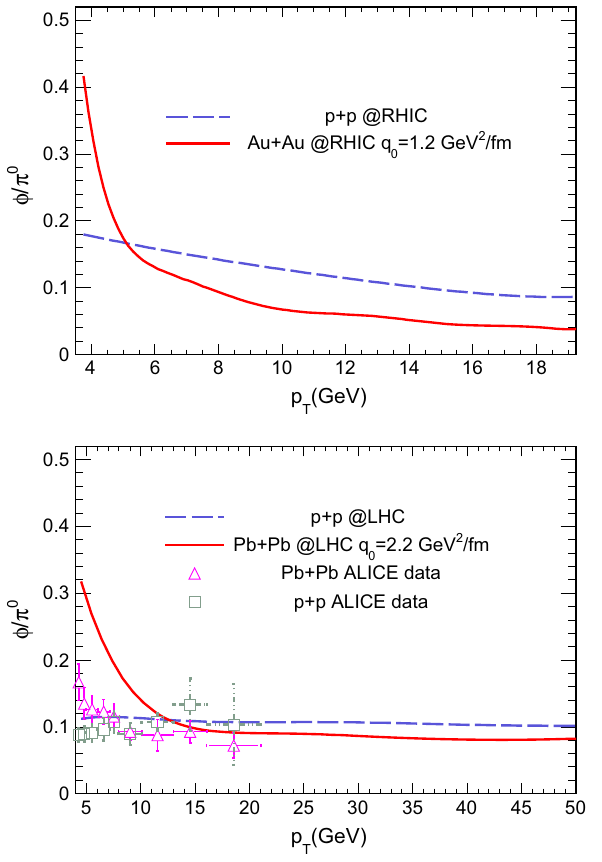
Fig. 6 Top φ/π 0 ratio as a function of p T in p + p and Au + Au collisions at the RHIC. Bottom φ/π 0 ratio as a function of p T in p + p and Pb + Pb collisions at the LHC, comparing with ALICE data [18]